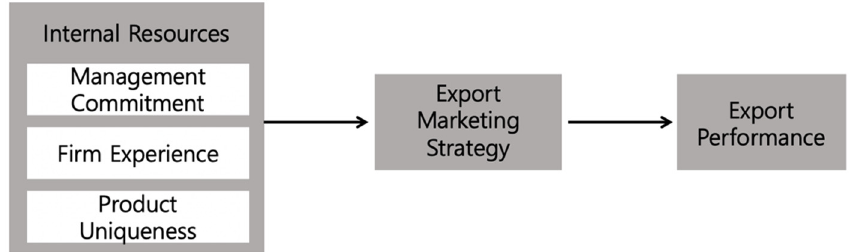
Figure 1. Internal determinants of EMS (partiallly excerpted from